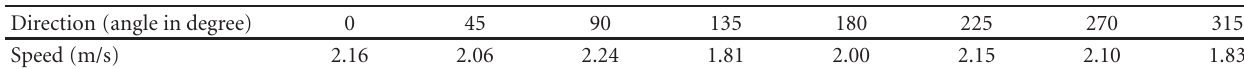
Table 4: Average speed in 8 di ff erent